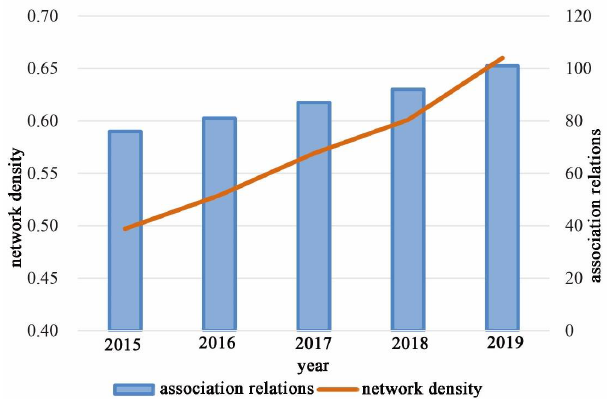
Figure 4. The network density and the number of association relations in 2019 increased by 32.80% and 32.89%, respectively, compared with the data in 2015. In summary, these between cities.